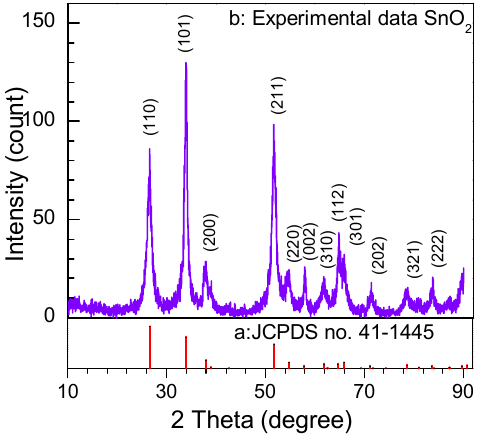
Figure 2. XRD pattern of the as-prepared SnO 2 nanosheets.